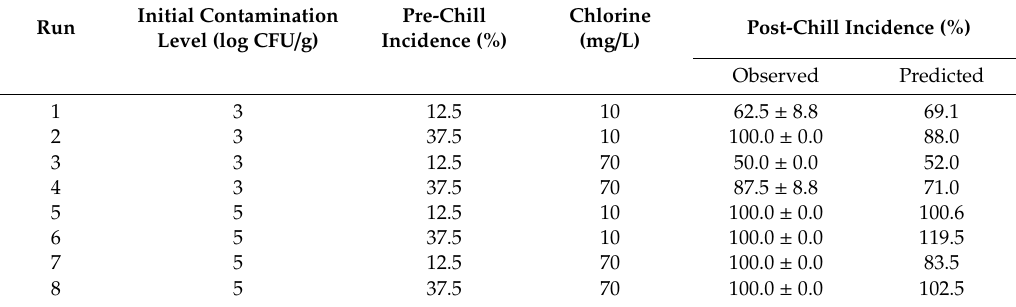
Table 3. Eight independent trials to validate the model for post-chill incidence in chilling process. Initial Contamination Level (log CFU /